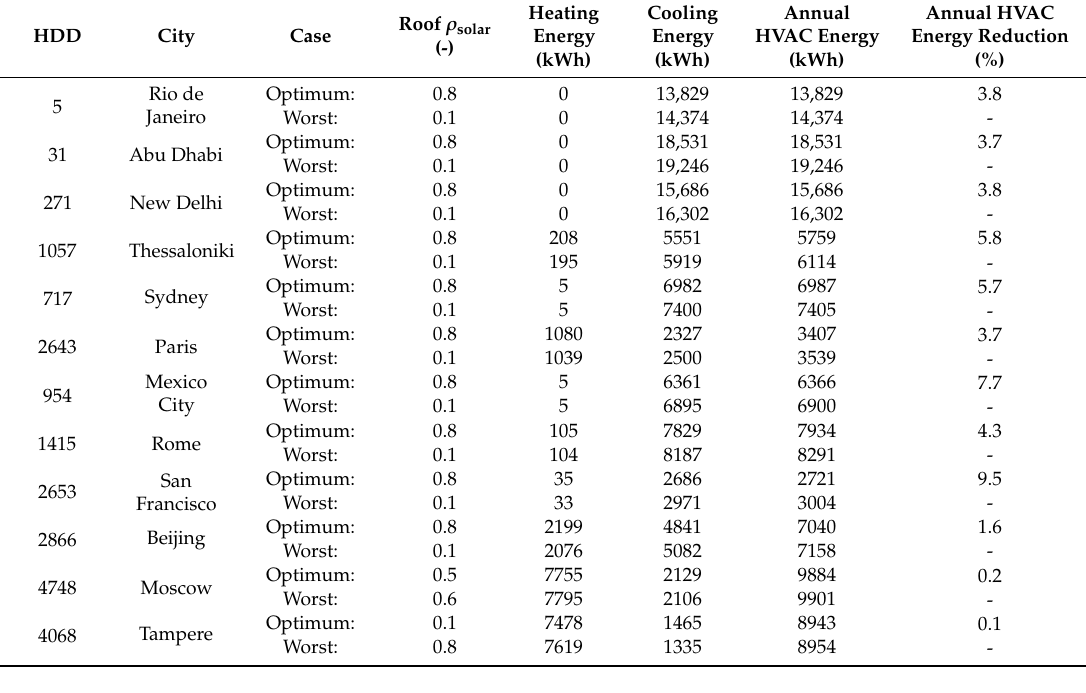
Table 3. Heating, cooling, and annual HVAC energy consumption and energy savings with the optimum roof solar reflectance compared to the worst performing scenario for the case study building in each climate zone.